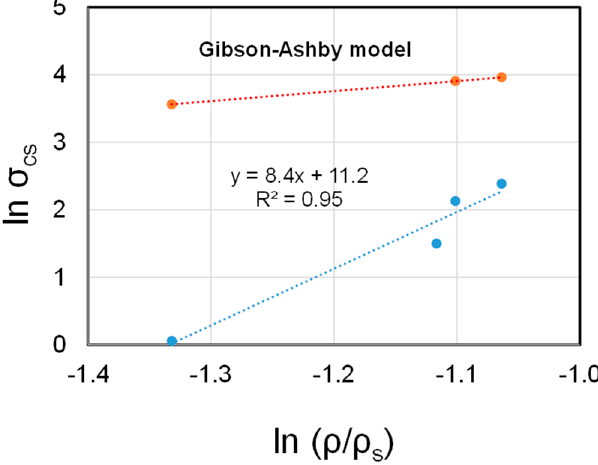
Figure 4. Crushing strength as a function of the relative density.